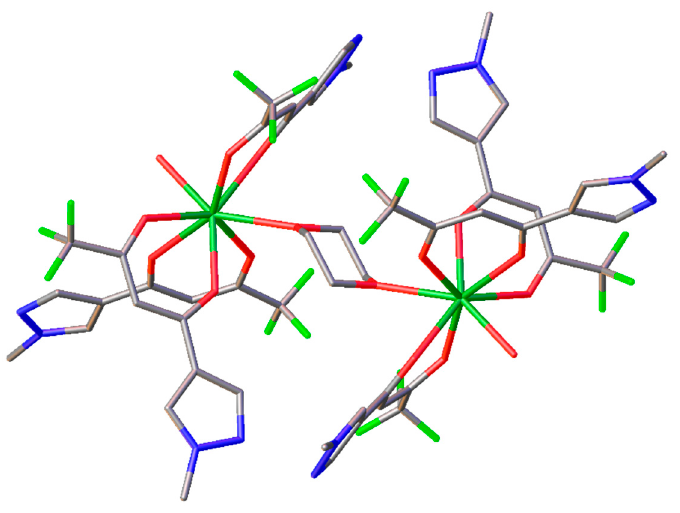
Figure 2 . View of the 2 molecule. Dioxane molecules (solvated), hydrogen atoms and thermal ellip- soids are omitted for clarity .